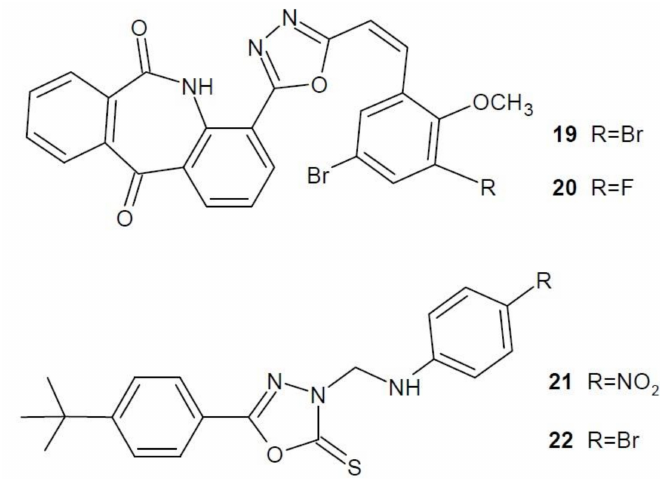
Figure 10. 1,3,4-Oxadiazole derivatives with activity of poly(ADP-ribose) polymerase